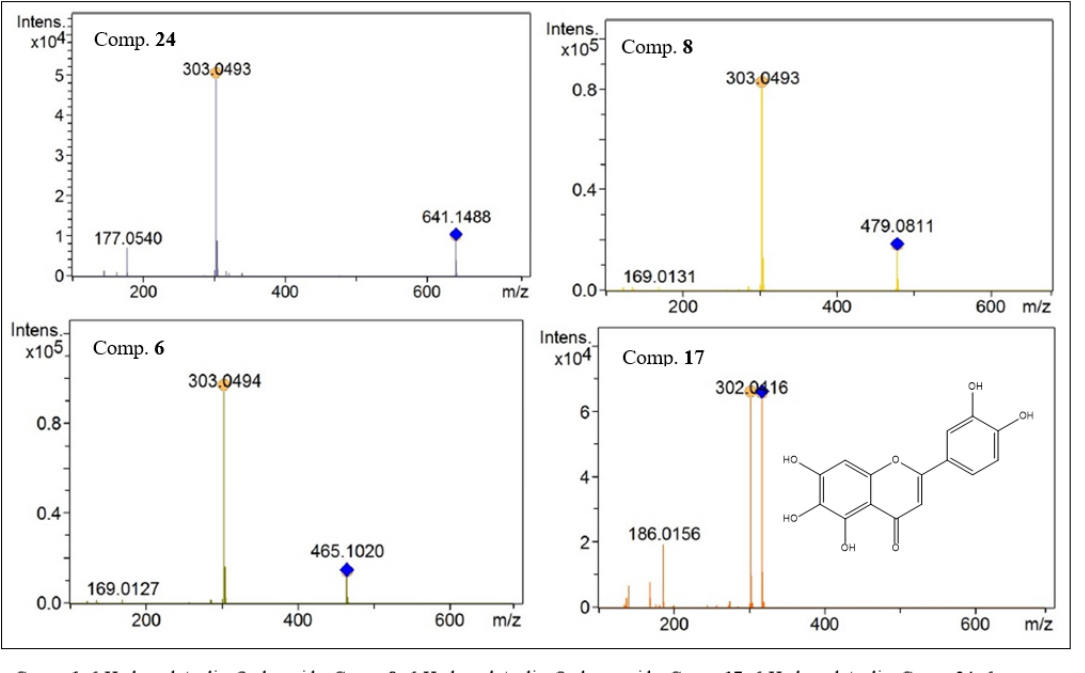
Figure 10. MS 2 spectra of flavones with 6-hydroxyluteolin-like aglycones present in the ethanolic extract of F. chica leaves.